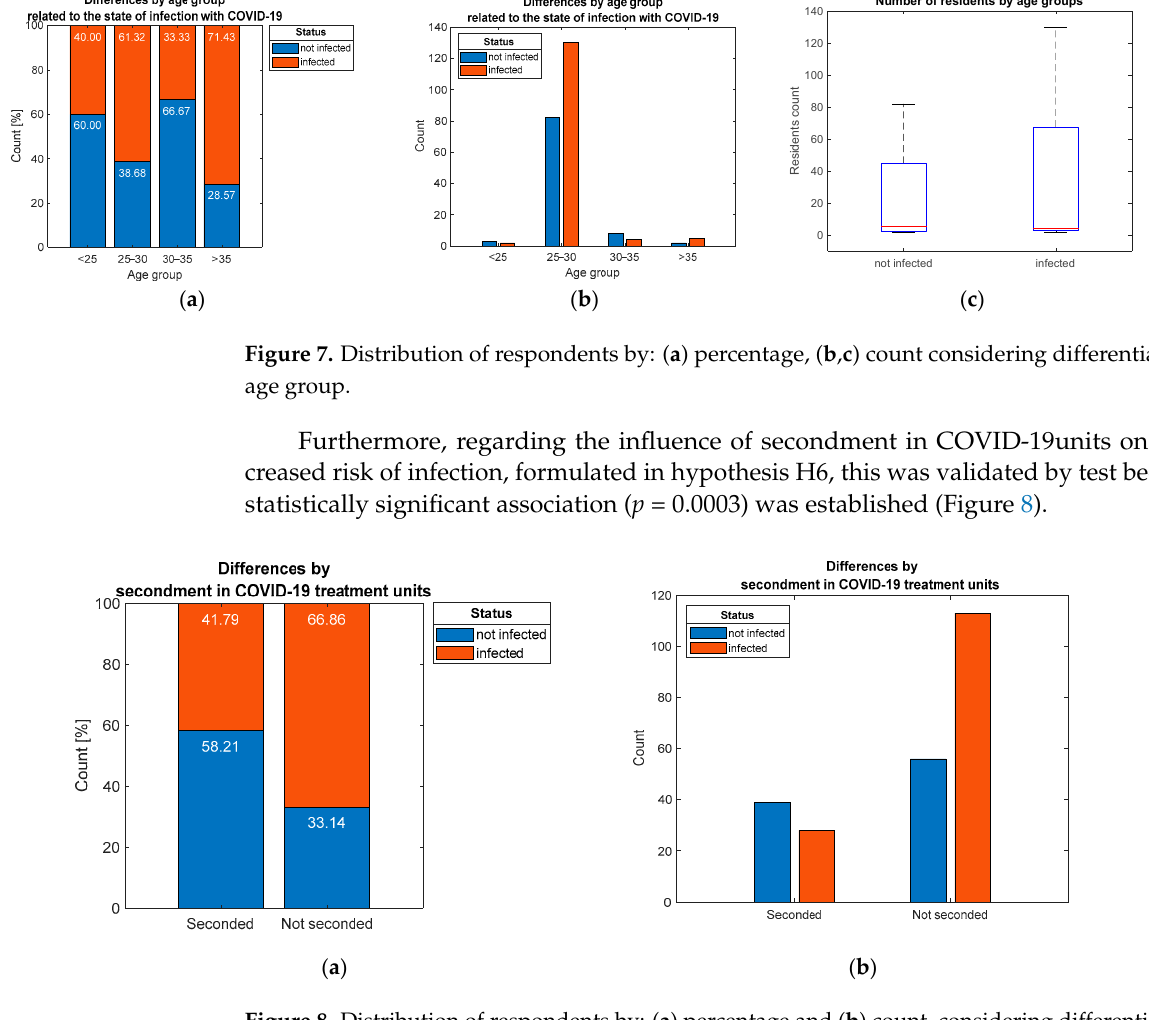
( c ) Figure 9. Distribution of respondents by: ( a ) percentage, ( b , c ) count considering differentiation by secondment period groups. 3.5. Assessment of Well-Being A relatively large number of residents who participated in this study have a low level of well-being, which is revealed by the general WHO well-being index of residents, with values of 13.8 ± 5.7. Table 4 shows the proportion of residents who have a personal preference for a new residency specialization. Along with this, there are residents who would choose a non-medical career, who have an average well-being index of 12.3 ± 5.7. By comparison, residents who preferred to continue their medical career have a higher index value (14.2 ± 5.6, p = 0.024). The WHO average well-being index of residents with a preference for a new medical specialization was 12.5 ± 5.4, which is also a statistically significant difference if it is compared with the index value of residents who follow their chosen specialization (14.2 ± 5.7, p = 0.015). The recorded values of well-being levels are explained due to the confirmation of hypotheses 1 and 6, whereby the risk of infection is associated with the treatment of patients with COVID-19, and secondment in COVID-19 units.